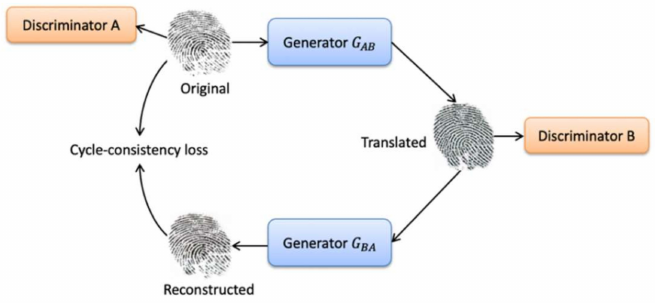
Figure 4. The architecture of